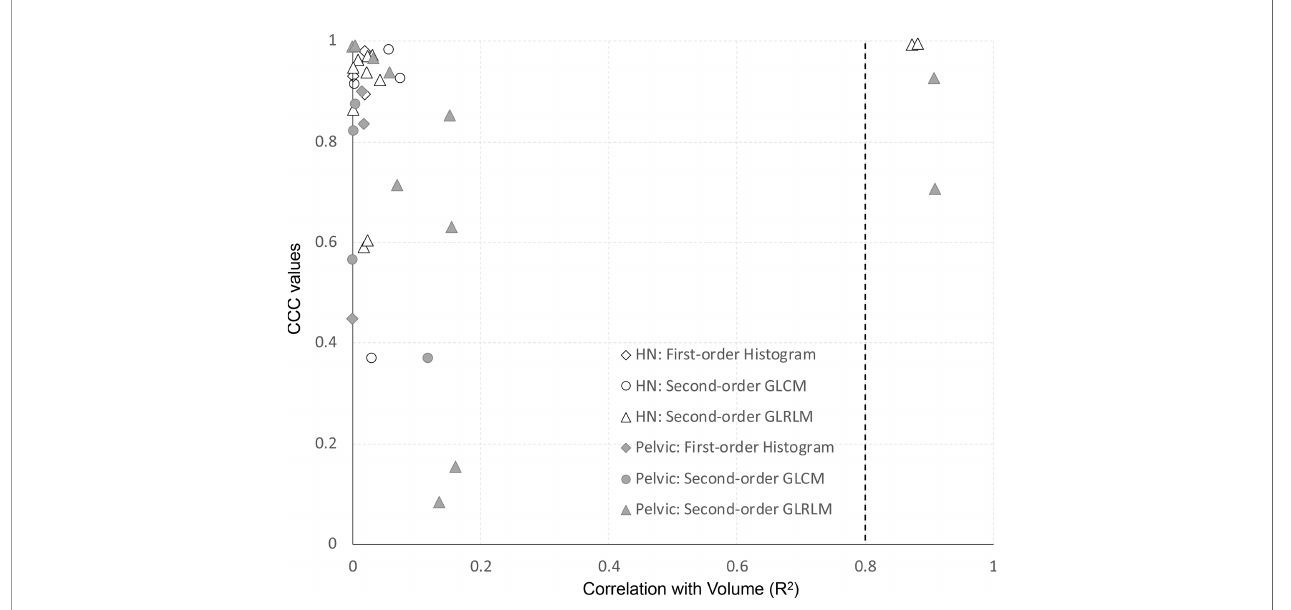
FIGURE 7 | Dependence of feature repeatability on volume separate in H&N and pelvic